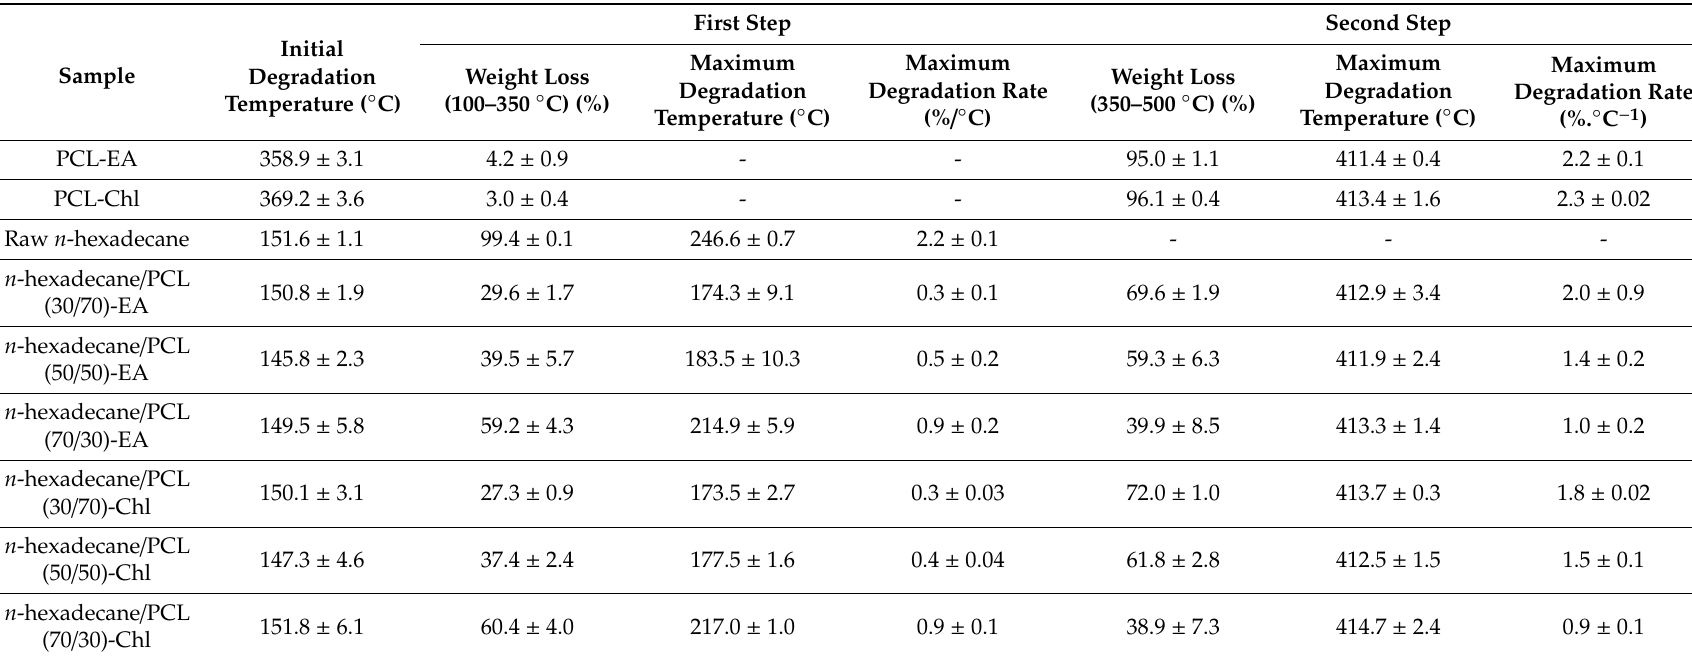
Table 3. Thermogravimetric data for of n -hexadecane, neat PCL microsphere and n -hexadecane microcapsules in inert atmosphere at a heating rate of 10 ◦ C · min − 1